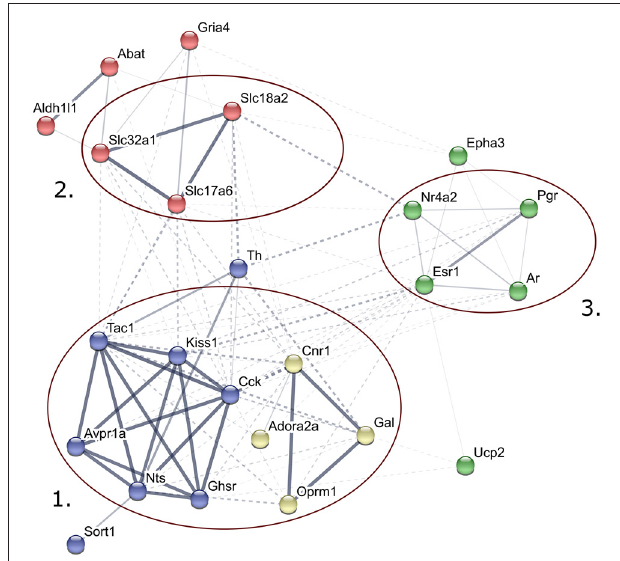
FIGURE 2 | Predicted interactions among proteins encoded by genes expressed differentially in late proestrus. Network visualization of the differentially expressed proteins was achieved by STRING v10 (http://string-db.org). The clusters of neuropeptides/neuropeptide receptors coupled to G proteins (1), solute carrier proteins involved in synaptic vesicle cycle (2) gonadal steroid hormone signaling pathway (3) are